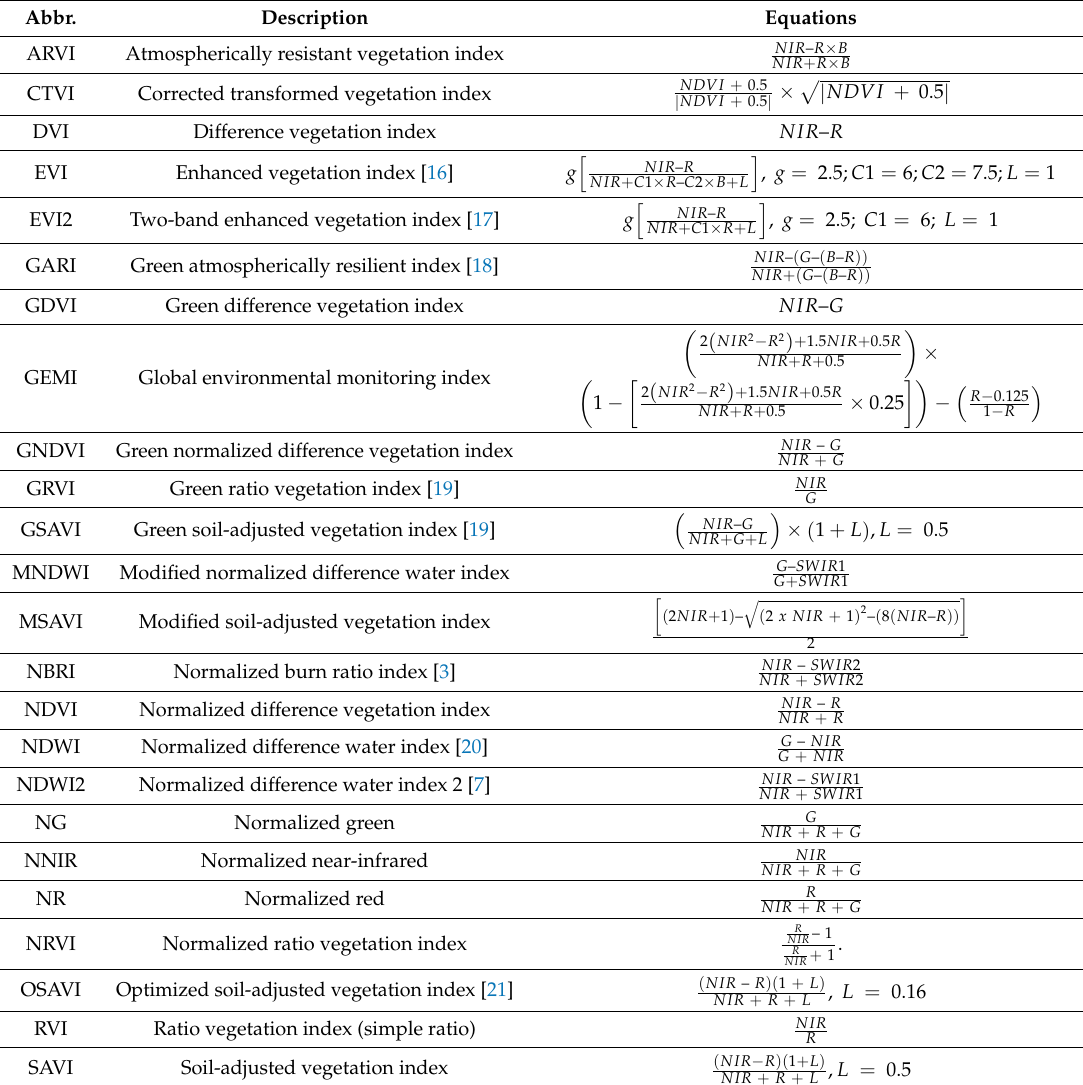
Table 1. The spectral indices and equations used in this